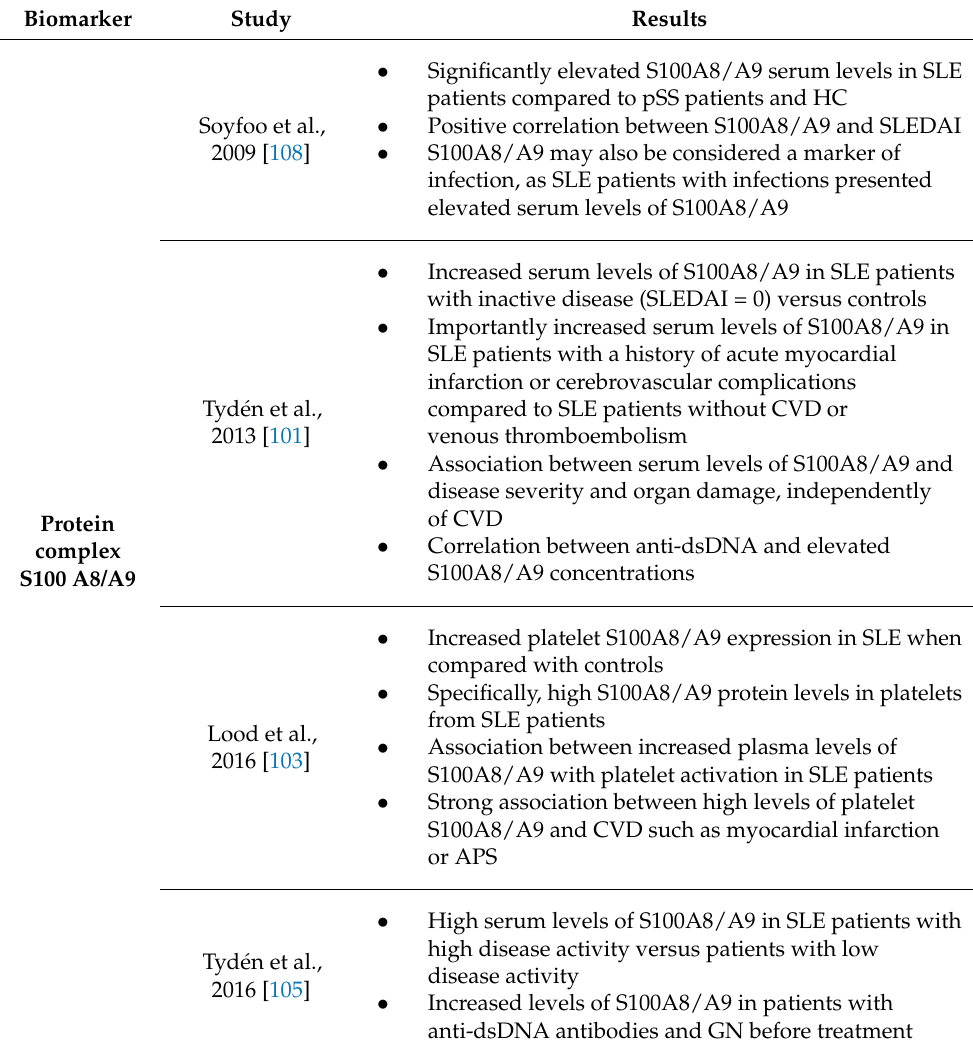
Table 6. Protein complex S100 A8/A9 in SLE